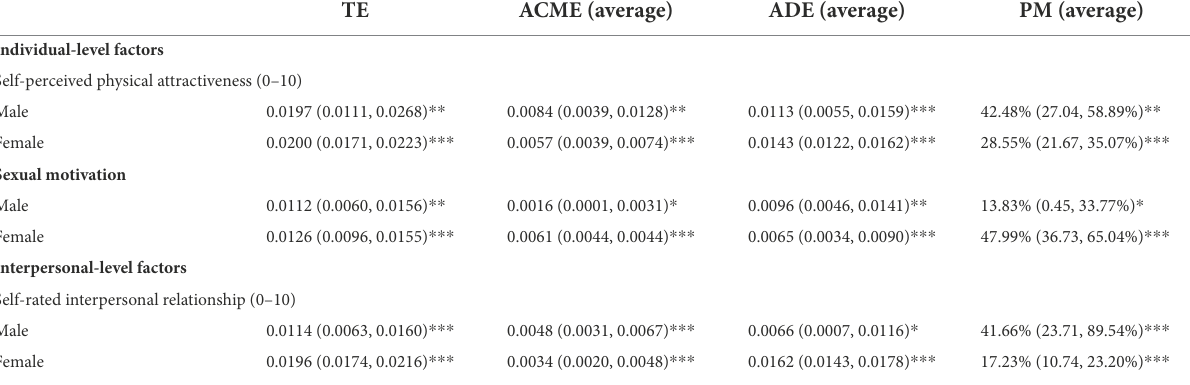
TABLE 3 The mediation effect of sexually selected traits between gender-role conformity score and sexual